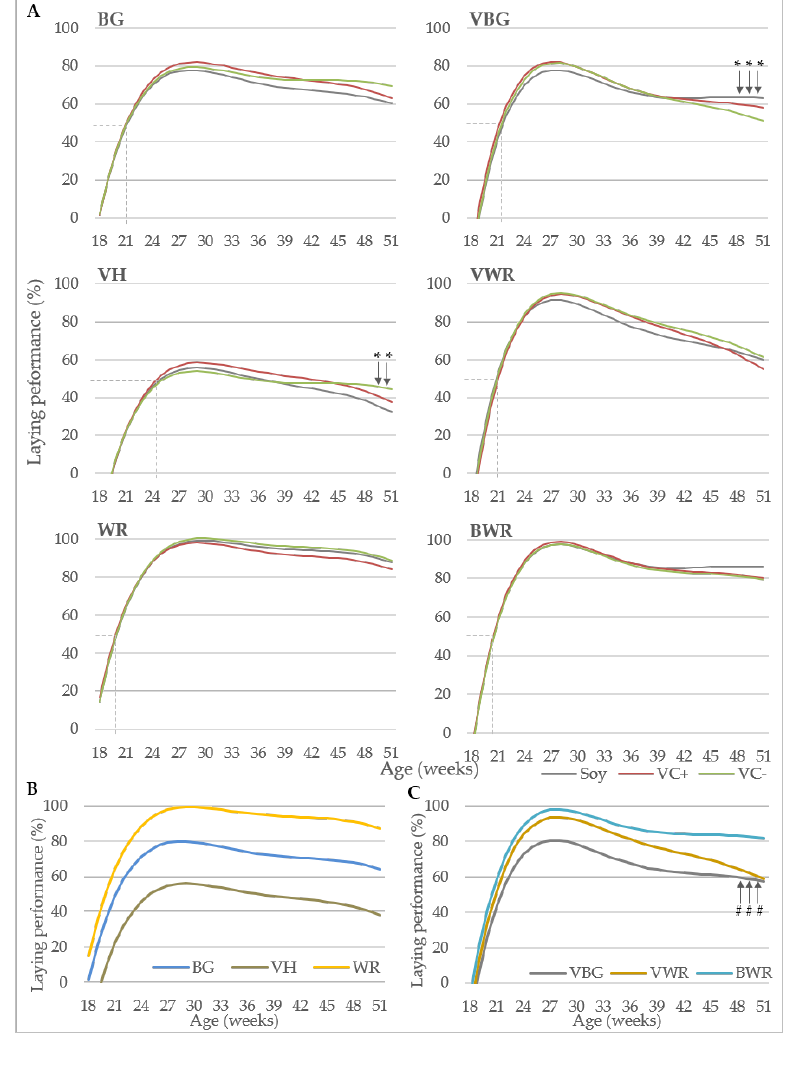
Figure 3. Laying performance. ( A ) Laying performance of six genotypes under the influence of different diets ( n = 2). Dashed lines indicate the age at 50% egg production. * mark significant differences between soy and VC− groups ( p < 0.05). ( B ) Comparison of laying performance of purebreds ( n = 6). All genotypes differ significant from each other in every week at p < 0.05. ( C ) Comparison of laying performance of crossbreds ( n = 6). # indicates that there is no significant difference between VBG and VWR in the respective weeks; at all other time points, all genotypes differ significantly at p < 0.05. BG: Bresse Gauloise, VH: Vorwerkhuhn, WR: White Rock, VBG: VH male x BG female, VWR: VH male × WR female, BWR: BG male × WR female.